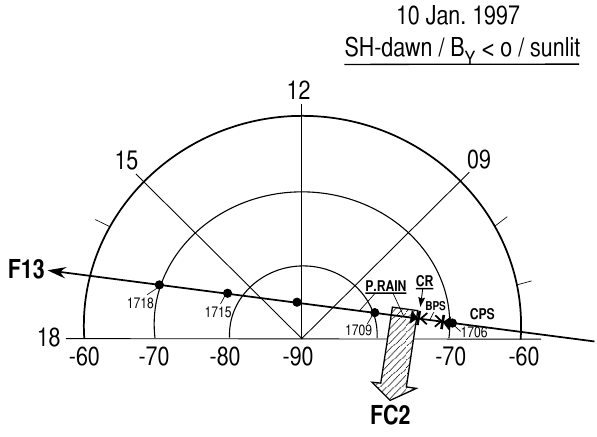
Fig. 24. DMSP F13 track across the polar cap in the Southern Hemi- sphere. The event gategory is: SH-dawn/ B y < 0